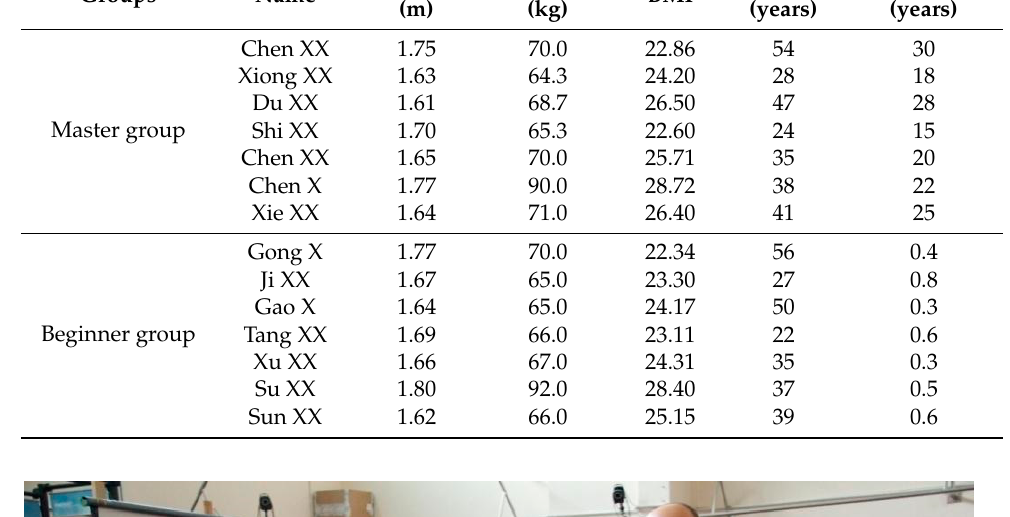
Table 2. Subjects’ detailed information.